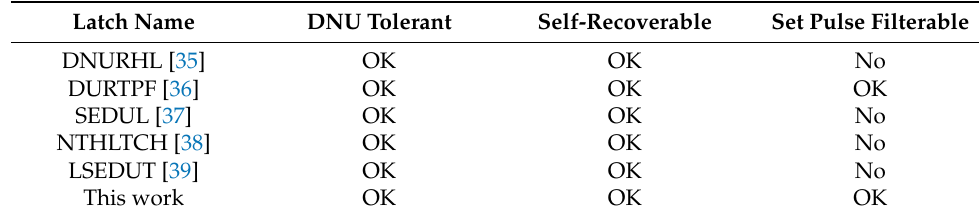
Table 1. Robustness comparison of the proposed DNURF with existing hardened latches.